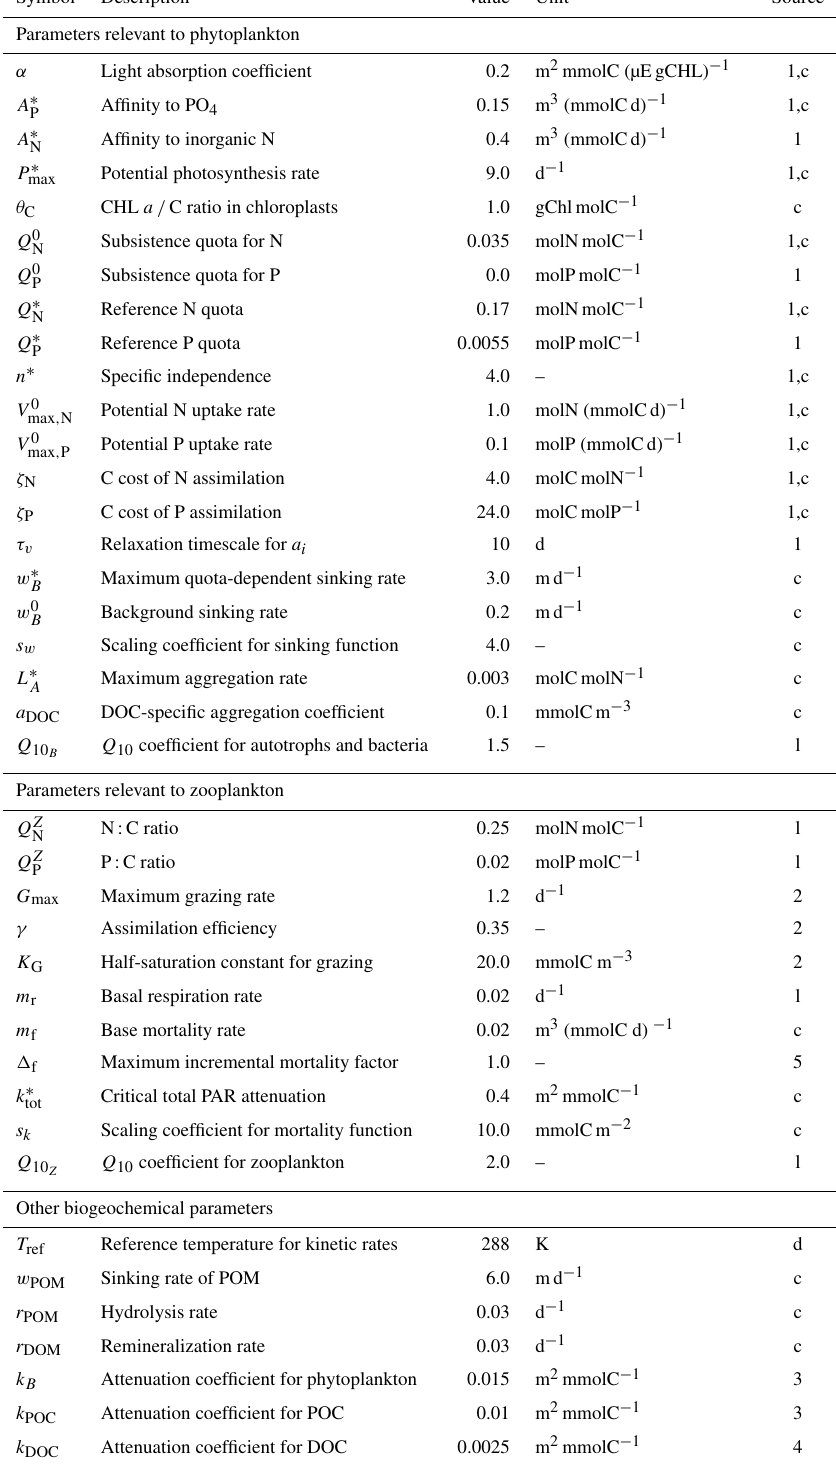
Table A3. Parameters of the pelagic module. Codes for sources: c – calibrated; a – assumed; l – typical literature value; d – by definition; (1) Wirtz and Kerimoglu (2016); (2) Hansen et al. (1997, for copepods); (3) Oubelkheir et al. (2005); (4) Stedmon et al. (2001); (5) Maar et al.